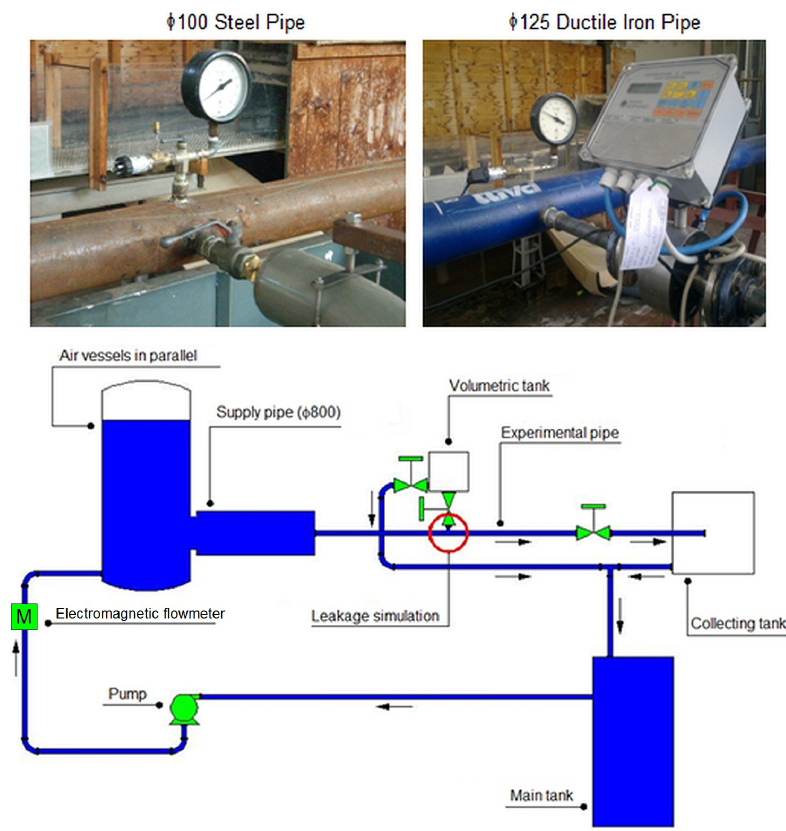
Figure 1. Experimental installation